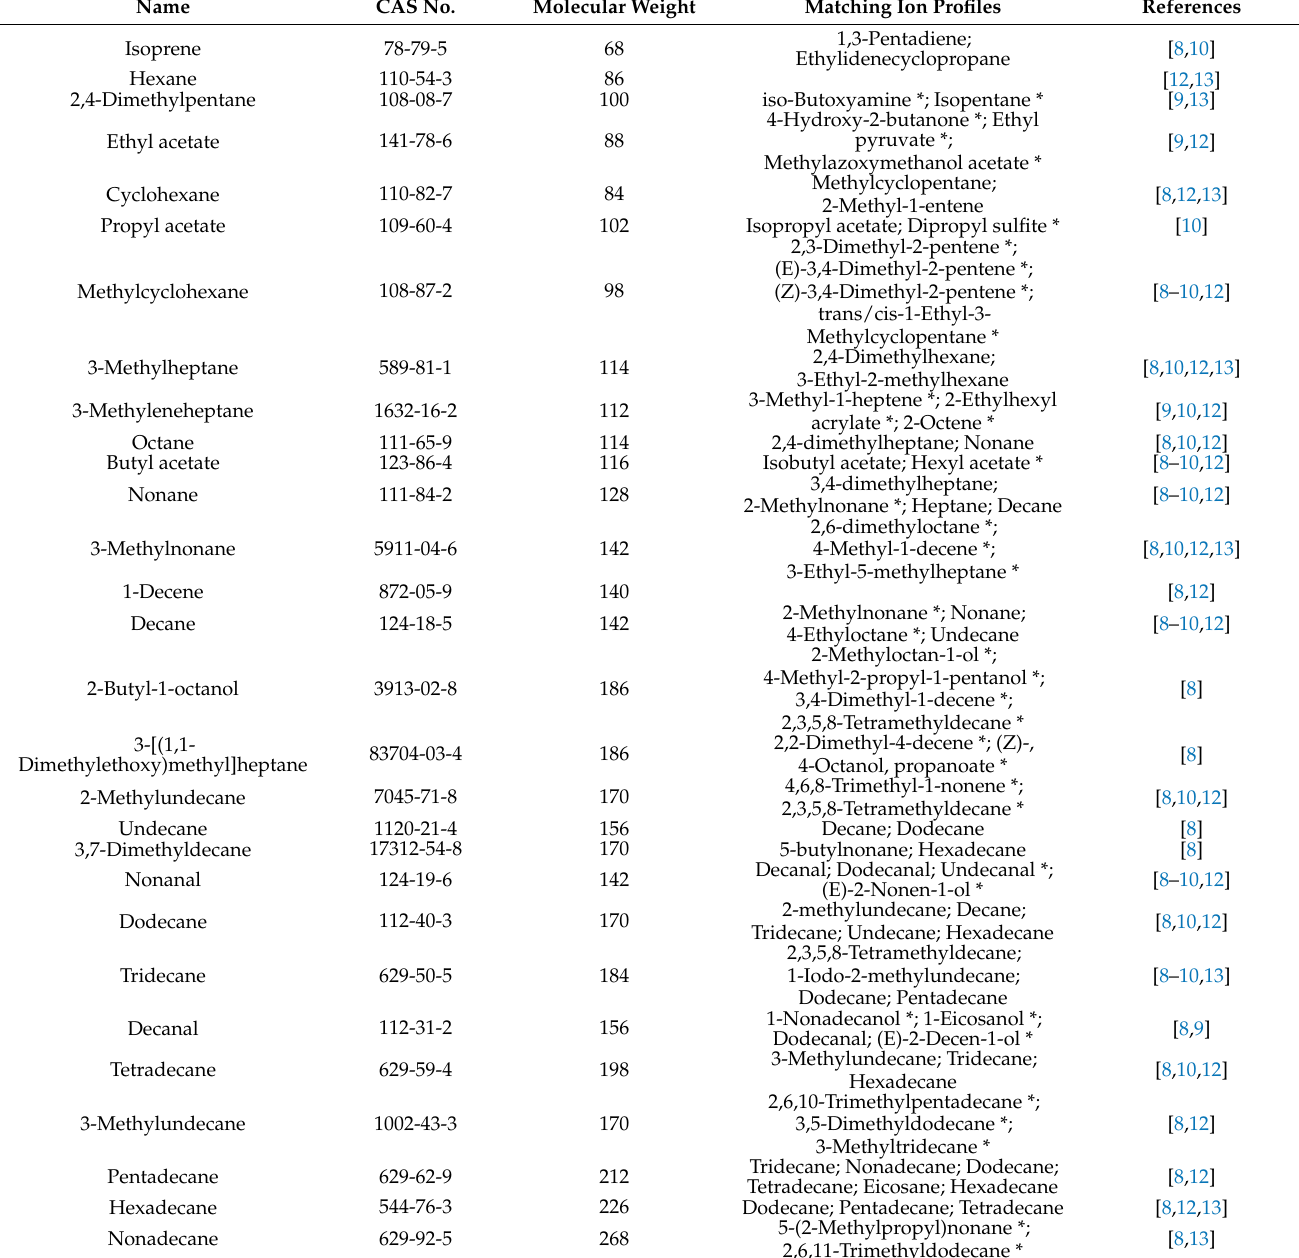
Table 2. The Volatilome-Associated Pulmonary Oxygen Response (VAPOR) library.